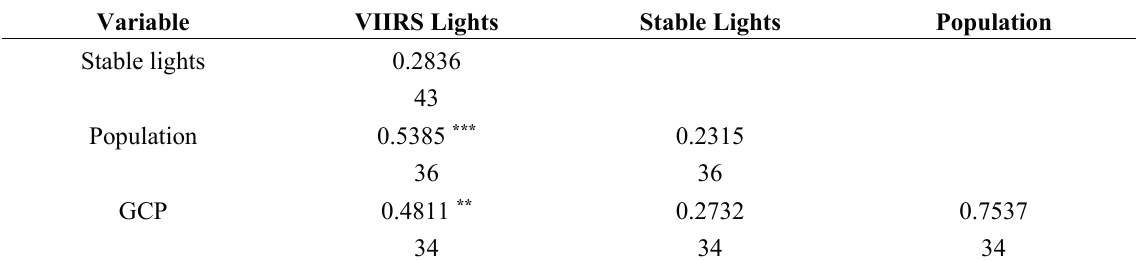
Table 2. Pairwise correlations for cells with population less than 100. Sample sizes are below coefficients ( ** p < 0.01; *** p < 0.001).